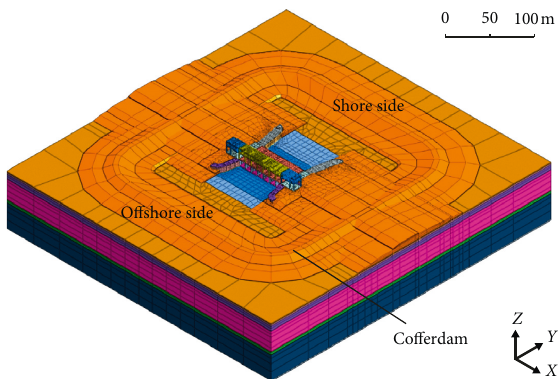
Figure 12: 3D numerical analysis model of sluice and its adjacent structures.